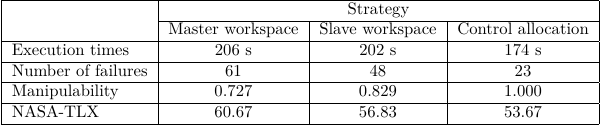
Table 1: Median execution times, number of failures, median manipulability (normalized), and me- dian NASA-TLX for the three strategies for 24 inexperienced